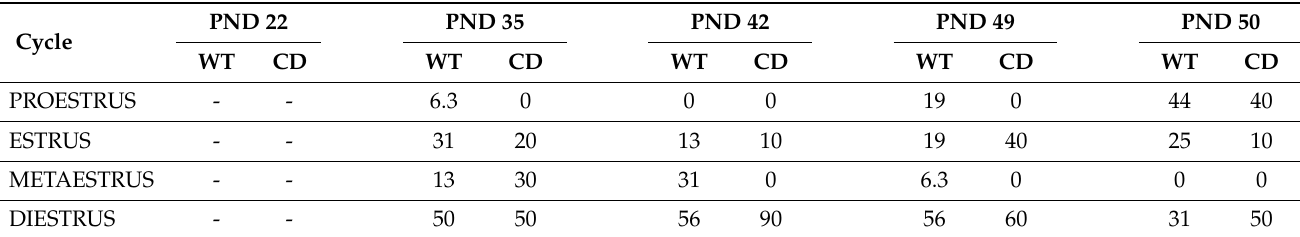
Table 2. Estrous cycle distribution of female mice during juvenile testing. Estrous cycle was assessed after each testing session (for PND 22 and PND 50 after the open field and acoustic startle tests; for PND 35, 42, and 49 after the social interaction tests). On PND 22 no estrous phase was detectable because of the sexual immaturity of all